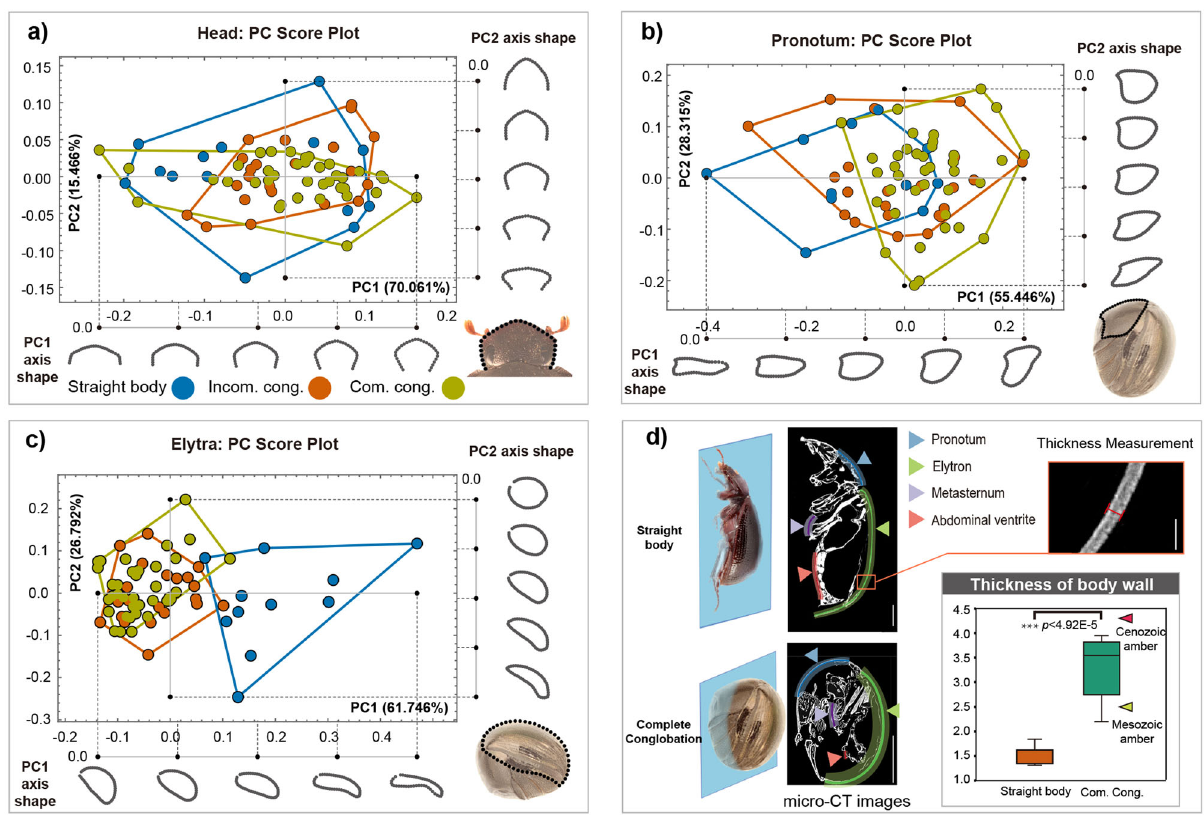
Fig. 4 Morphological analysis of conglobation-related characters in Ceratocanthinae. a – c Geometric morphometric analysis of basic shapes: a head; b pronotum; and c elytra. The PC score plot shows the distribution of species with three archetypes based on the morphological variation in test traits along principal component axes (PC1 and PC2). The PC1 and PC2 axis shapes show deformations at certain positions along the axes. The fi gure in the lower right- hand corner shows landmarks describing the basic shape of the head, pronotum and elytra used in the geometric morphometric analysis. d Morphometric analysis of micro-CT images of body wall thickness in species of scarab beetles (Scarabaeoidea) with straight bodies or complete conglobation (Supplementary Table 2). The box plot shows the ratio of outer (elytra plus the pronotum) to inner (abdominal ventrites plus the metasternum) surface thickness. Scale bars in micro-CT images: 1 mm; Scale bars in thickness measurement image: 0.1 mm. Green – yellow triangle: Palaeopycnus circus sp. nov. from Mesozoic amber, red triangle: Nesopalla succini sp. nov. from Cenozoic amber. ∗∗∗ : p <